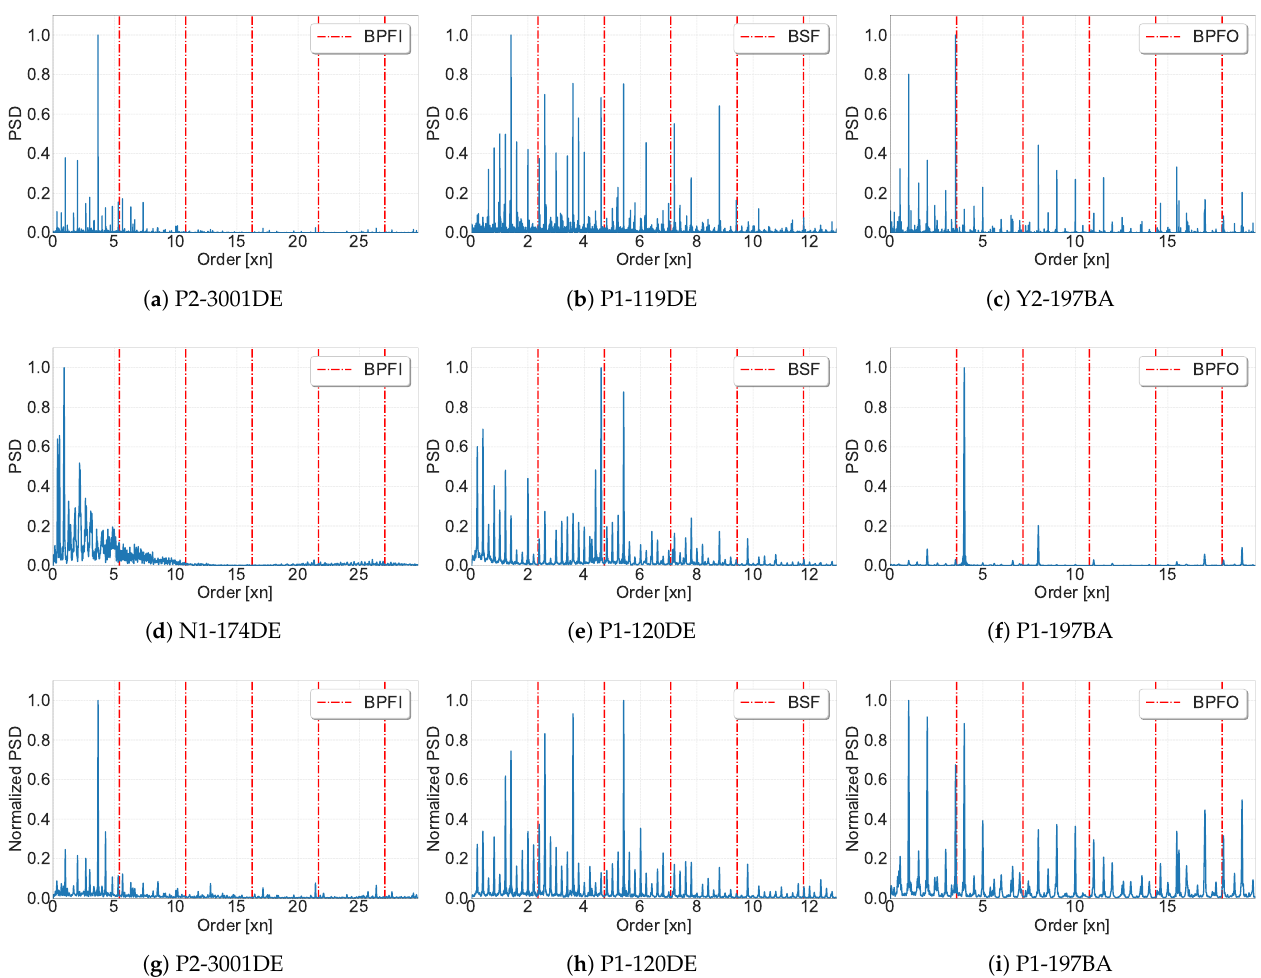
Figure 7. Assigned labels after visual inspection of envelope spectra (obtained from PSD) estimated by sliding spectral kurtosis (SSK, top row), spectral entropy (SE, middle row), and sliding spectral entropy (SSE, bottom row). One example record is displayed for each considered failure: Left column (inner race (IR)), middle column (ball), and right column (outer race